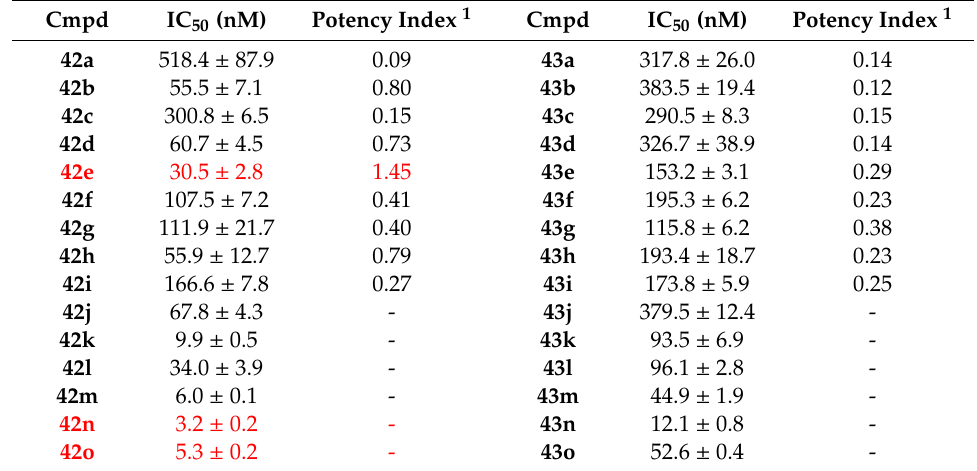
Table 5. Inhibition of Ee AChE by naphthalene pyranopyrimidinones 42a – i and 43a – i and naphthalene pyrimidinimines 42j – o and 43j – o (data from [95,96]).